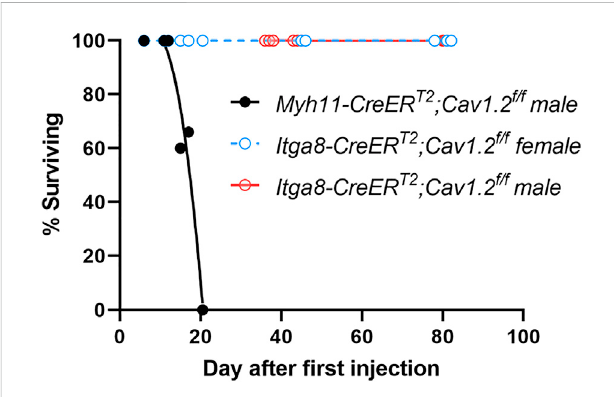
FIGURE 1 Survival curves for 21 Myh11-CreER T2 ;Cav1.2 f/f mice and 21 Itga8- CreER T2 ;Cav1.2 f/f mice, with the latter separated by sex. Curve fi ts were made using non-linear